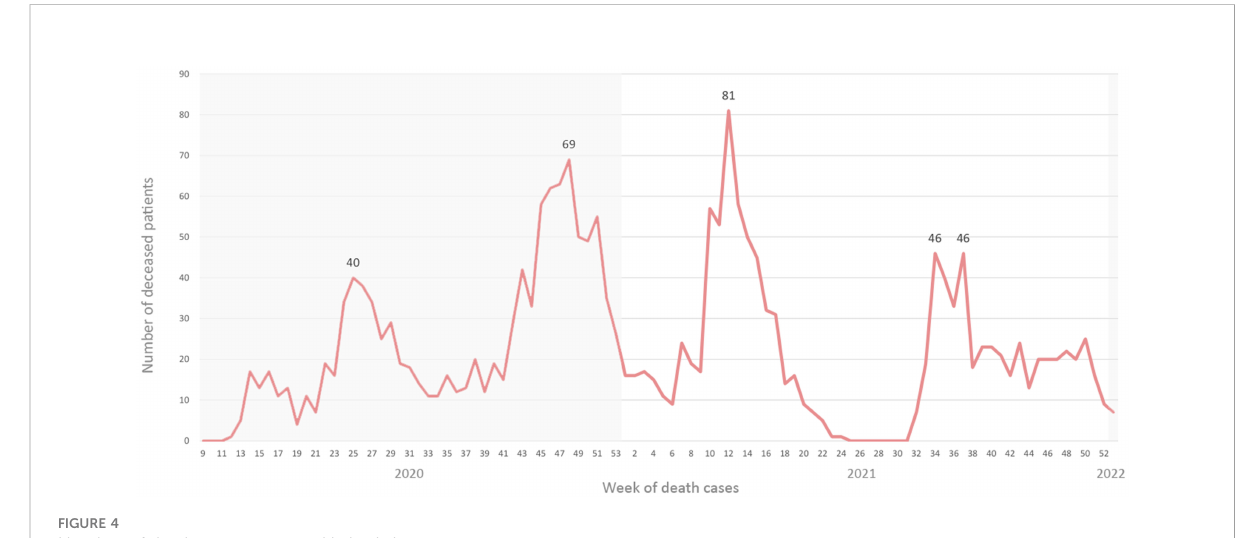
FIGURE 4 Number of death cases on a weekly basis in a two-year